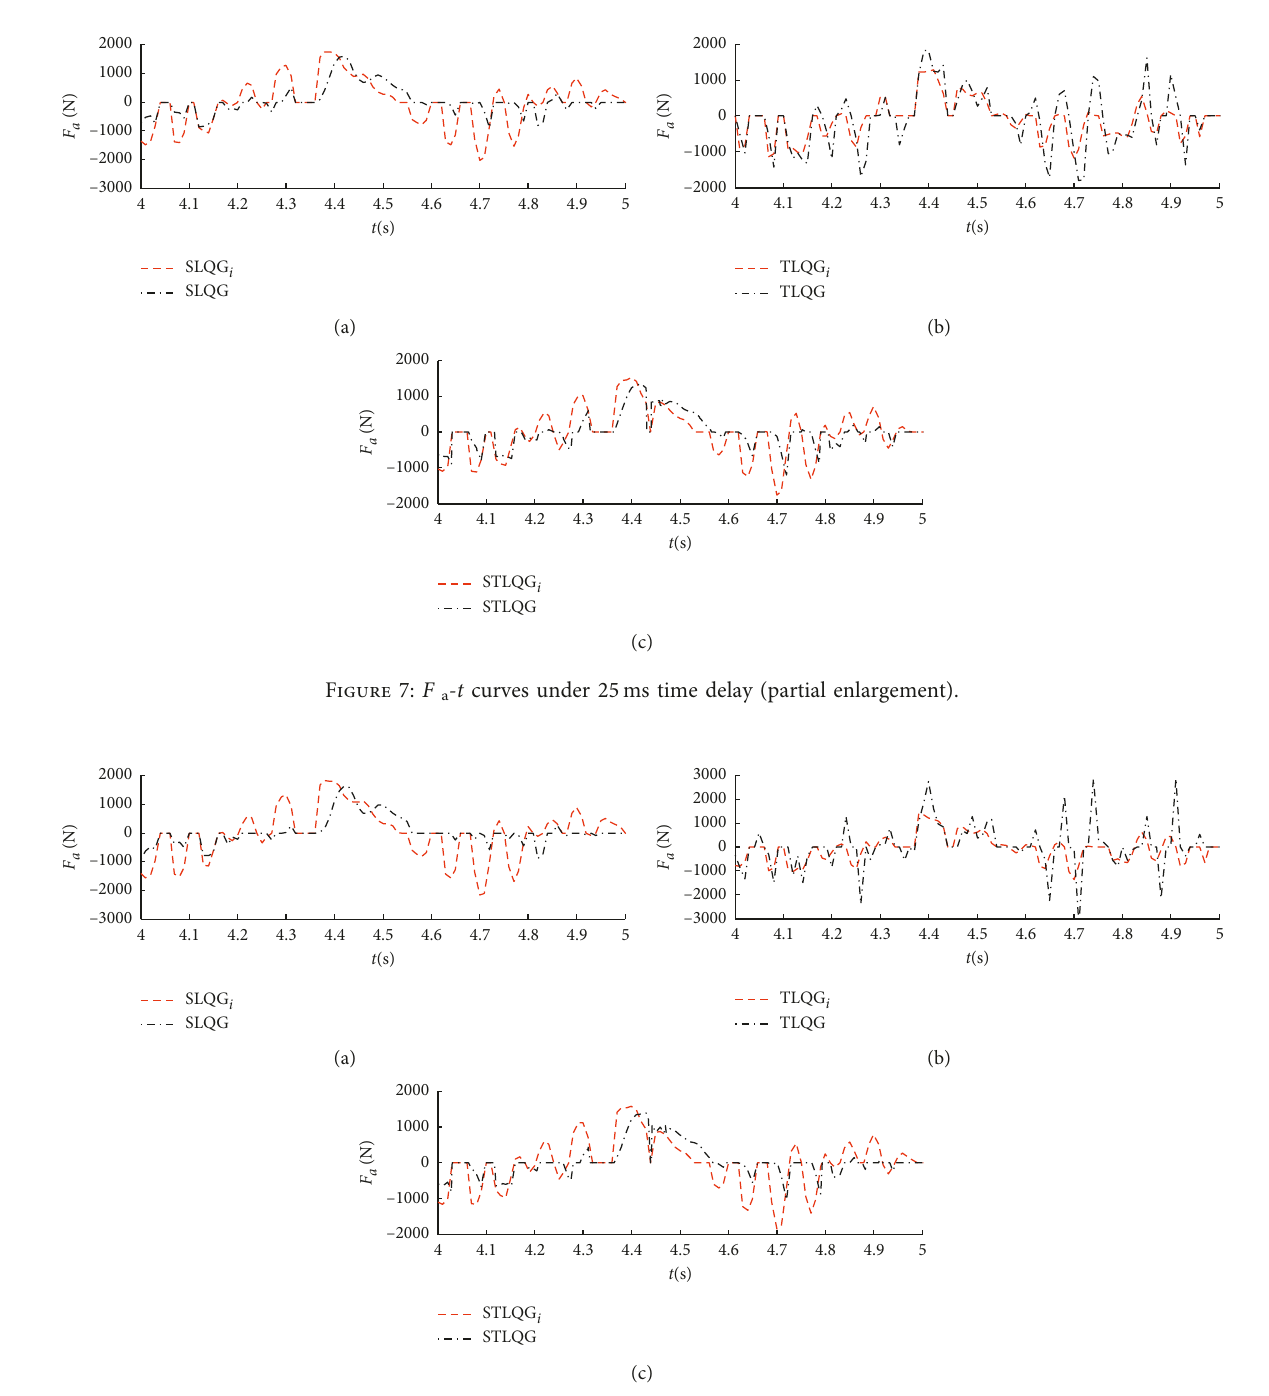
Figure 8: F a - t curves under 30ms time delay (partial